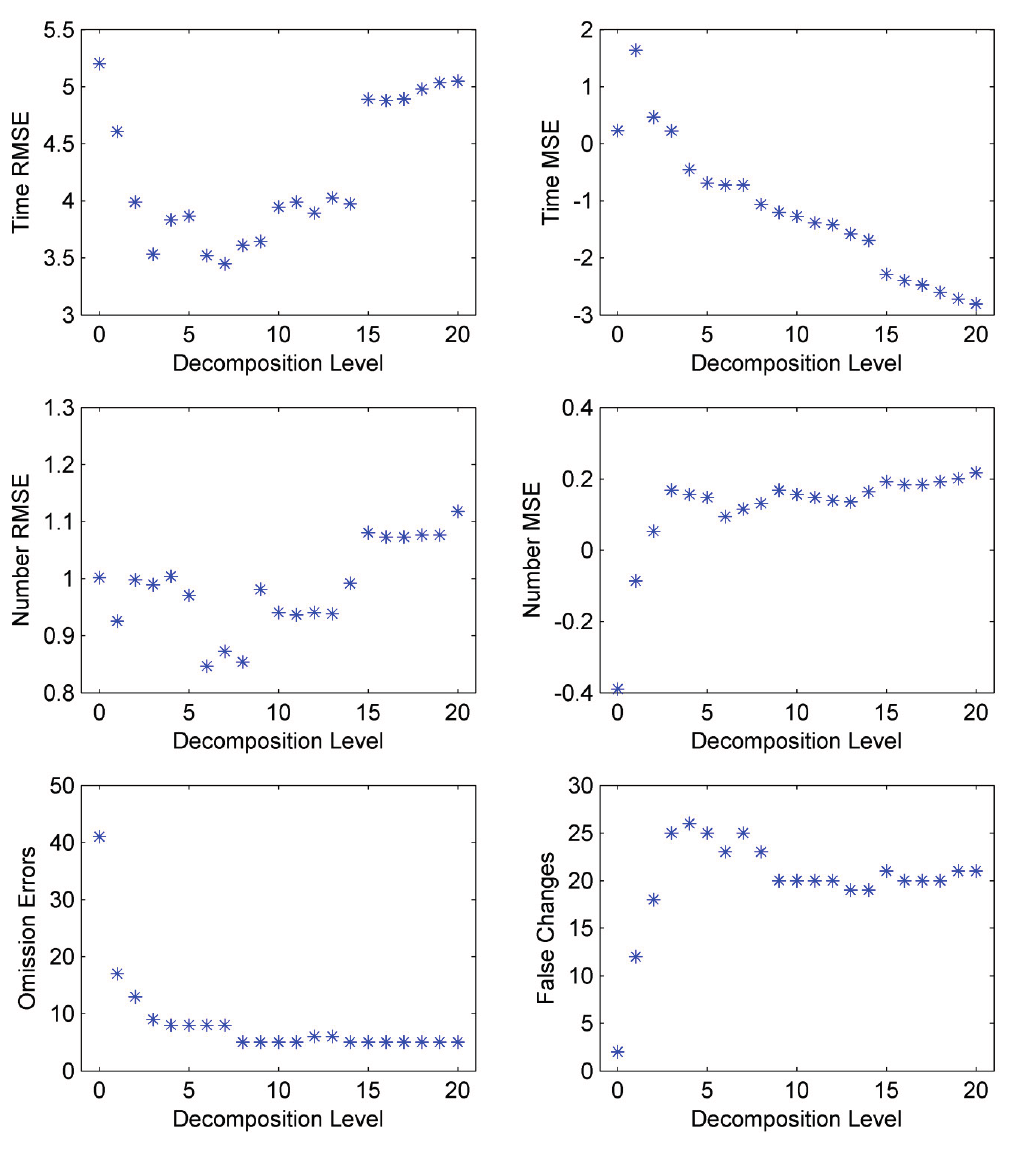
Figure 6. Plots of smoothing effect on the accuracy indices, which were calculated based on independent random samples. The accuracy indices as shown on the Y-axis are the RMSE and MSE of time step (Time RMSE and Time MSE), the RMSE and MSE of the number of changes (Number RMSE and Number MSE), the omission errors of changes in percentage (Omission Errors) and the false changes in stable time series in percentage (False